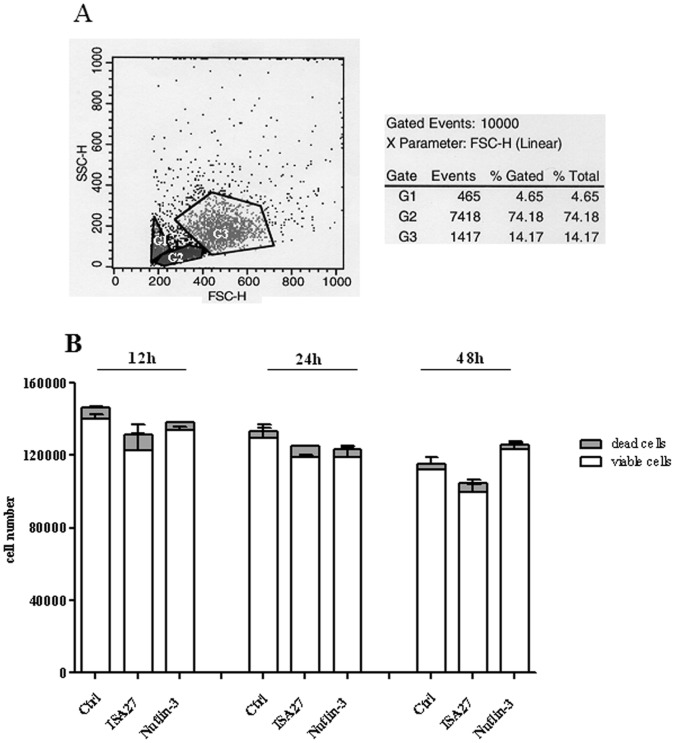
Lack of ISA27 toxicity in an in vitro human cell model (lymphomonocytes).
6A) Scatter cytogram analysis of cell populations from peripheral blood: Scatter cytogram analysis showing cell separation by size and granularity (G2 = lymphocytes; G3 = monocytes). One representative experiment is presented. 6B) Time-response of human lymphomonocyte viability following ISA27 treatment: lymphomonocytes were treated with 2.5 µM ISA27 or 10 µM Nutlin-3 for 12, 24 and 48 h. The figure shows the viable cells and dead cells counted by Trypan blue exclusion at the indicated times. Data represent the means of three independent experiments performed in duplicate; bars, SEM. No significant differences were observed between MDM2 inhibitor-treated and untreated-control viable or dead cells at each incubation time.